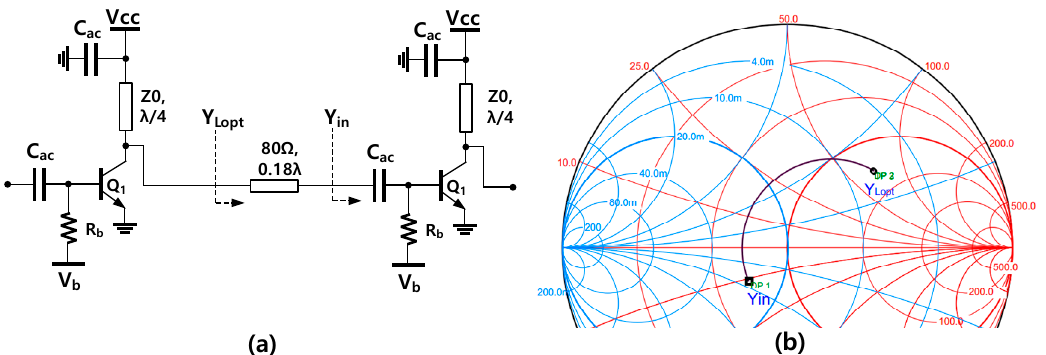
Figure 6. A simple interstage impedance matching circuit: ( a ) the possible circuit implementation, ( b ) impedance transformation on smith chart.